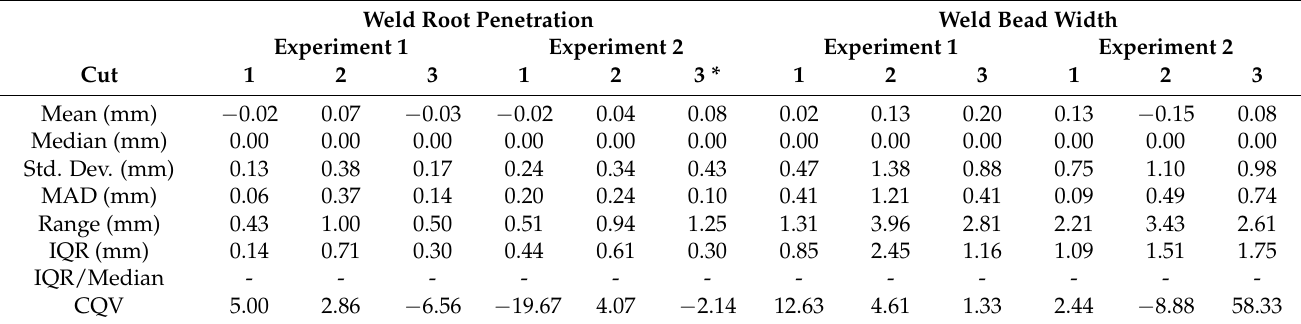
Table 5. Summary of the deviation of the two measured features for the 9 specimens against the median value. (*) analysis that does not comply with Gaussian distribution. Weld Root Penetration Weld Bead Width Experiment 1 Experiment 2 Experiment 1 Experiment 2